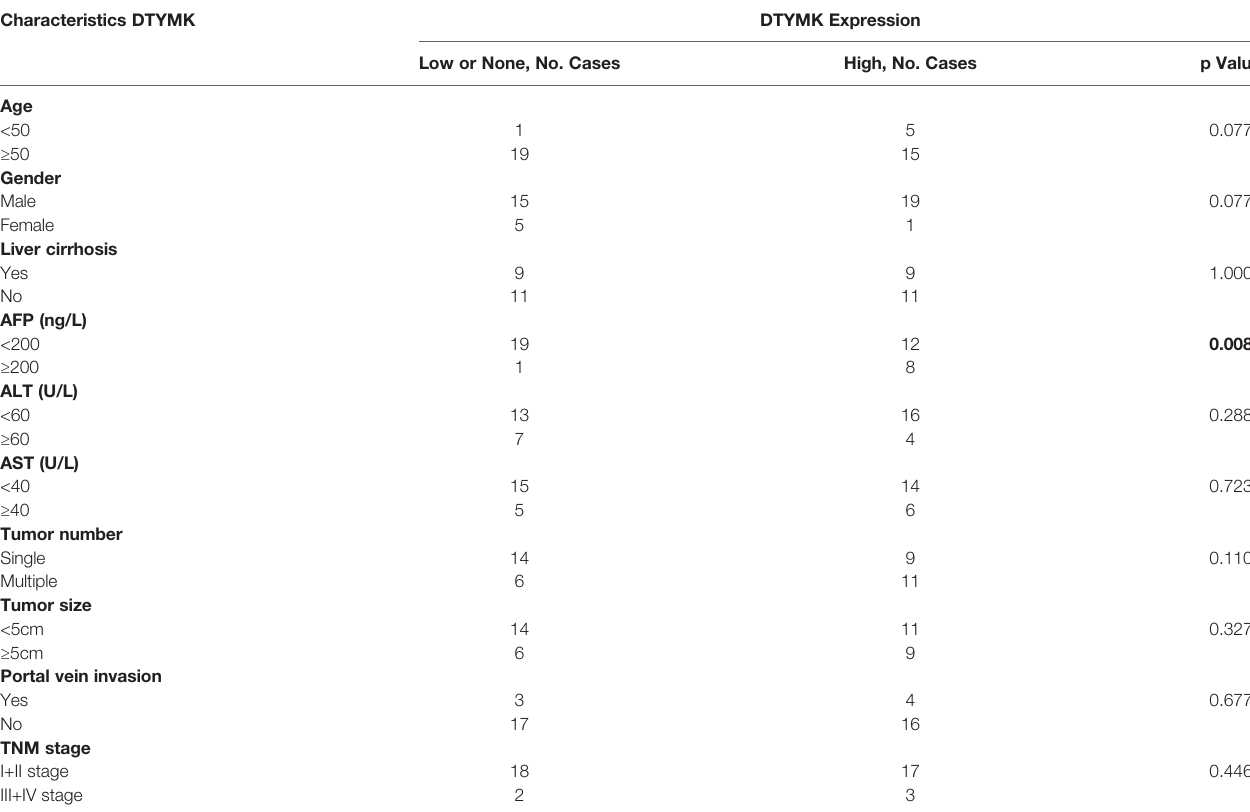
TABLE 2 | Correlation between DTYMK expression and clinicopathologic characteristics of HCC patients. Characteristics DTYMK